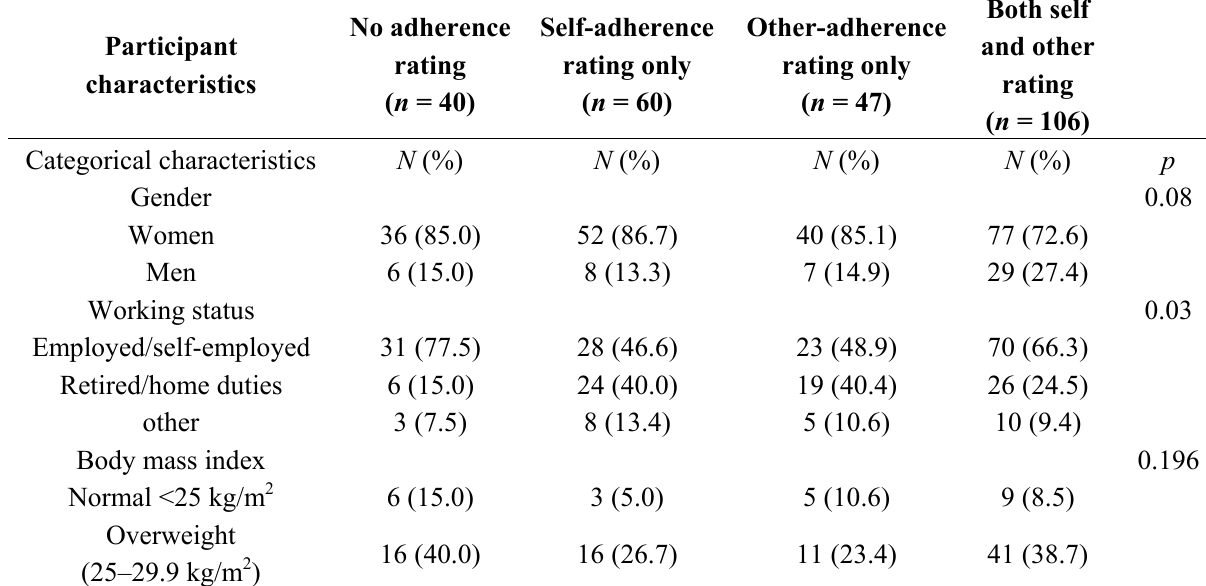
Table 1. Characteristics of participants by availability of adherence rating ( N =